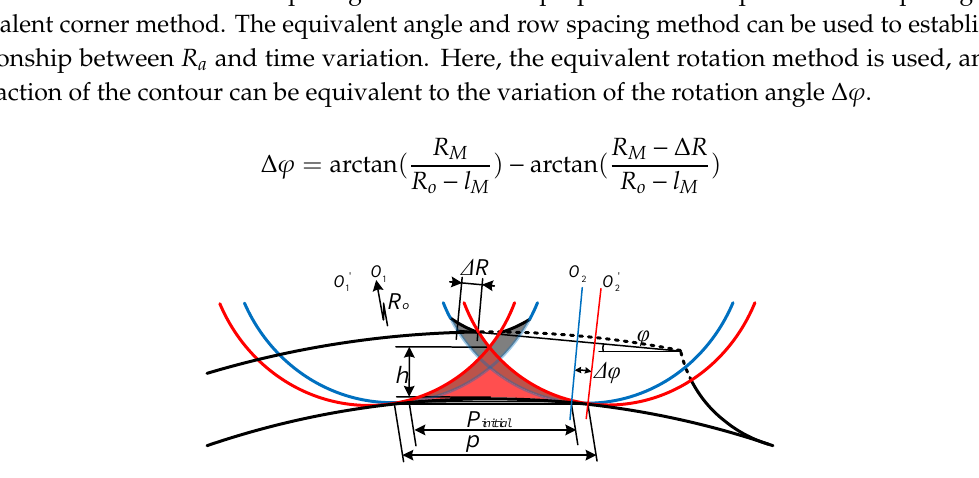
Figure 5. Diagram of the relationship between wear and residual height.